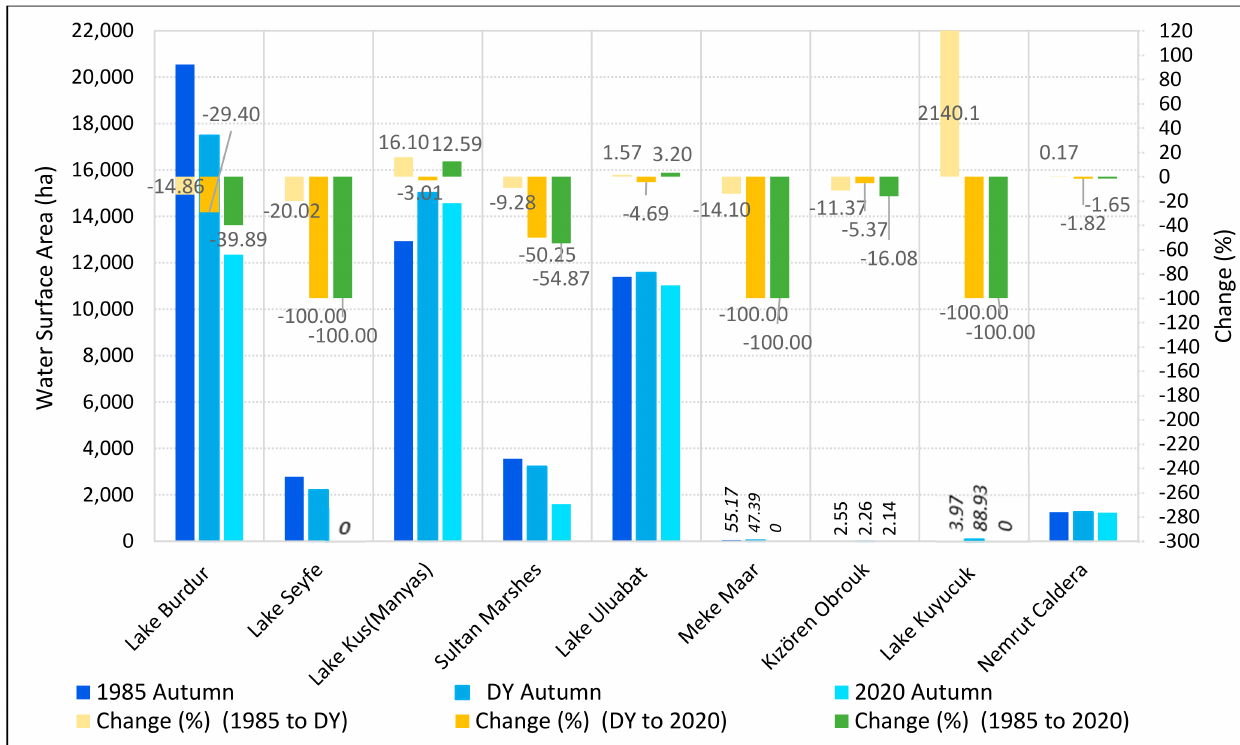
Figure 4. Water surface areas and changes from 1985 to DY and DY to 2020 (%) in the inland Ramsar sites in